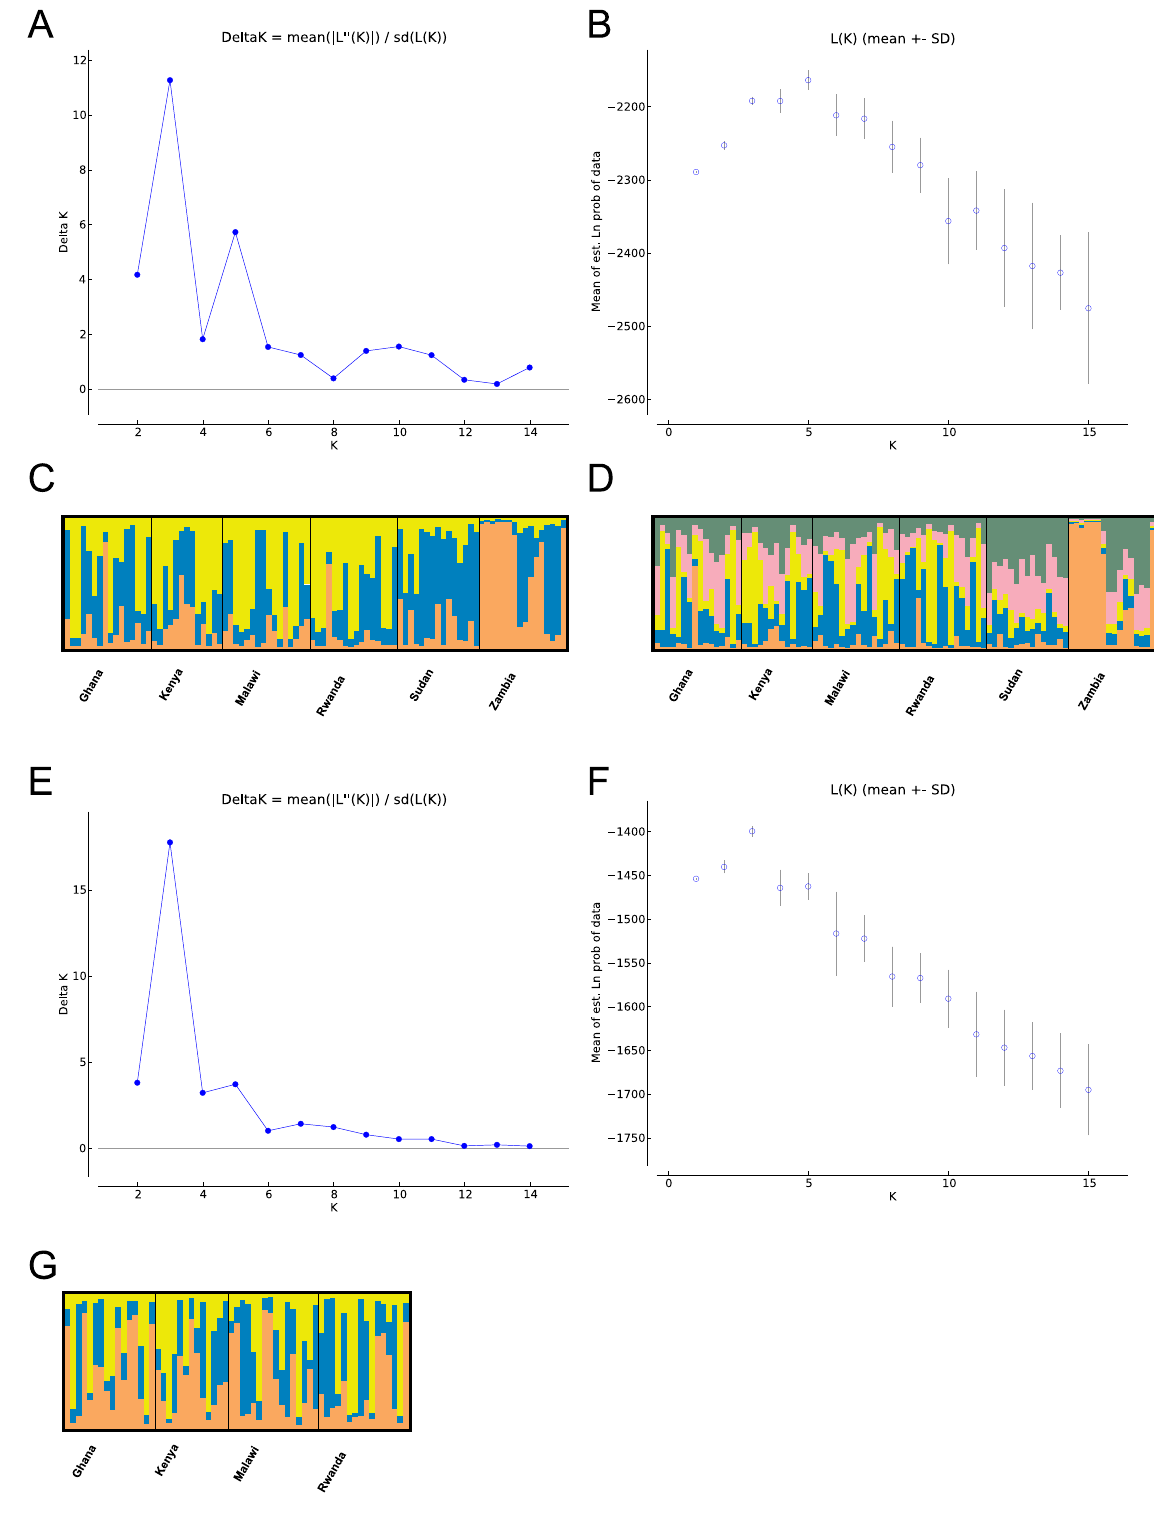
Figure 2. Genetic structure of FAW as assigned by STRU CTU RE analysis of microsatellites. Panels ( A ) to ( D ) show the results of STRU CTU RE with all six countries. Panel ( A ) shows the DeltaK , Panel ( B ) shows the LnPr(K) for each cluster. Panel C shows the admixture plot for the three genetic clusters based on DeltaK . Panel D shows the admixture plot for 5 genetic clusters based on LnPr(K) . Panels E to G show the results of STRU CTU RE carried out to assess substructure hierarchically. Panel ( E ) and ( F ) show the DeltaK and LnPr(K) for each cluster respectively. Panel ( G ) shows the admixture plot for the three genetic clusters based on both DeltaK and LnPr(K)